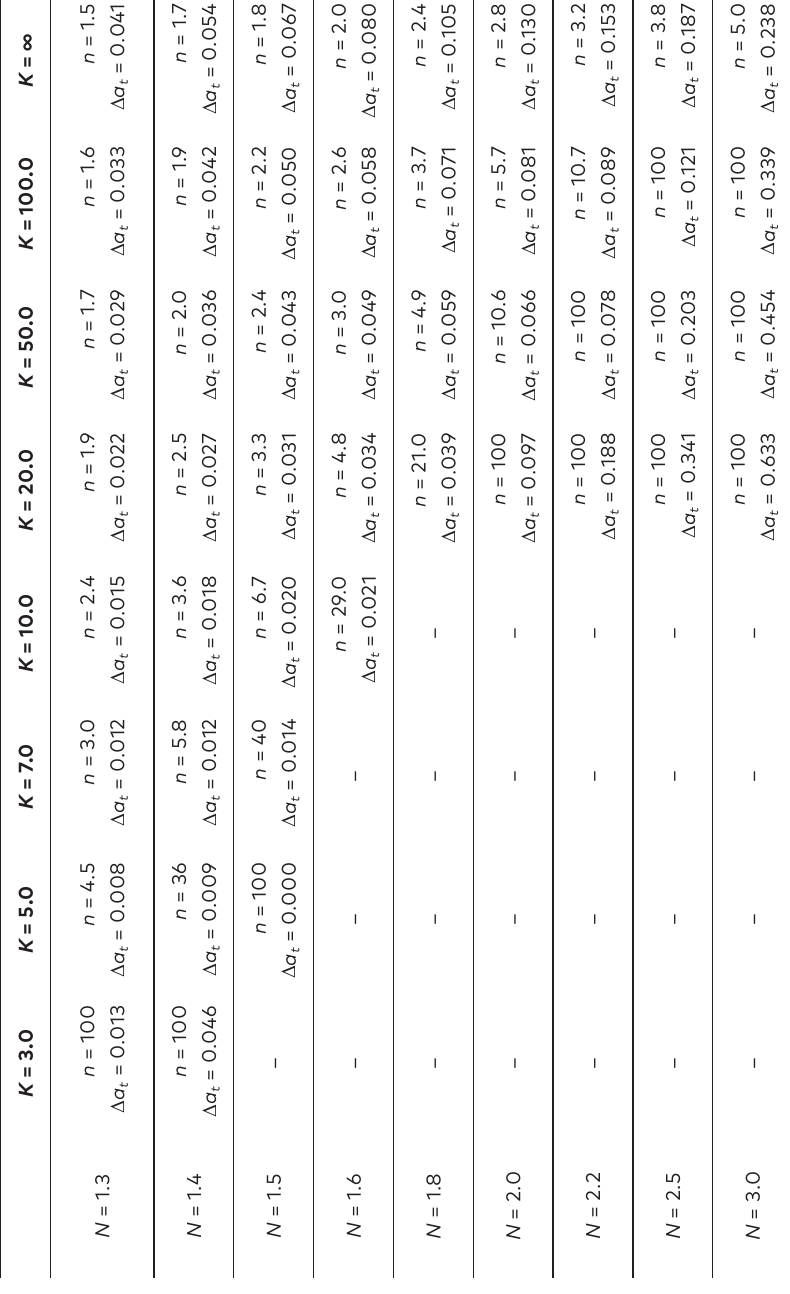
Table 3. Optimum n -values when parameters N and K